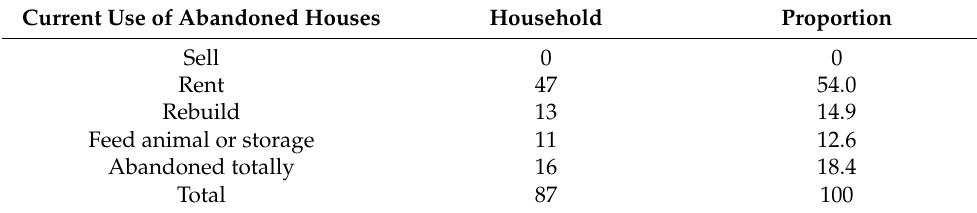
Table 4. Questionnaire results for the current uses of abandoned